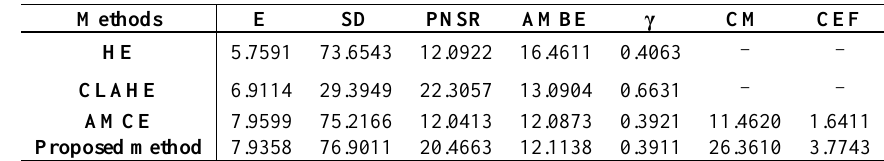
Table 3 . Comparison of the proposed method's performance to that of other commonly used contrast enhancement